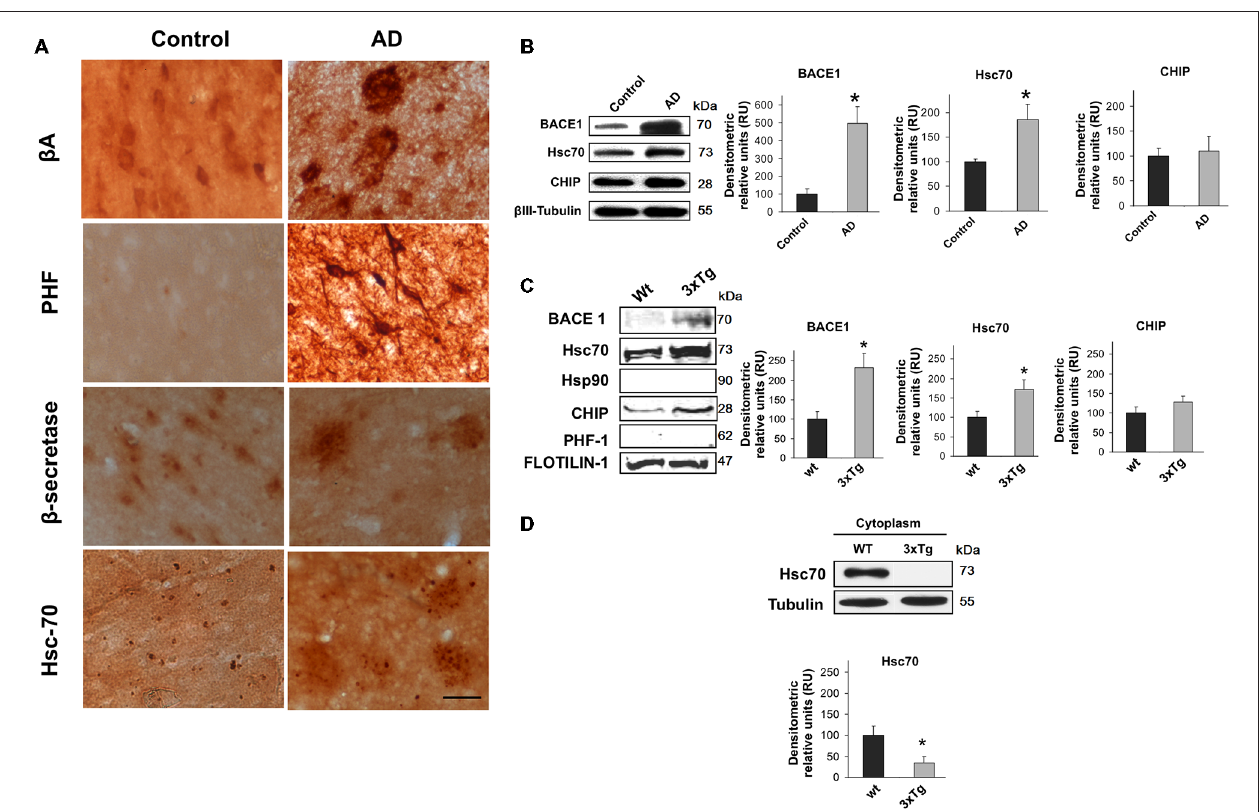
FIGURE 1 | BACE1 and Hsc70 in AD-affected human brains and in lipid rafts from triple-transgenic Alzheimer’s disease mouse brains. (A) β -amyloid, PHF-1, BACE1 and Hsc70 immunoreactivity in the temporal gyrus of AD-affected brains (AD) and control brains. 40 × magnification; scale bar: 20 µ m. n = 4. (B) BACE1, Hsc70 and CHIP Western blotting from the temporal gyrus of AD brains (AD); normal human brains were used as controls. A representative plot is shown. β III-tubulin was used as a loading control. Densitometric quantification was performed; RU = relative units. n = 4, ∗ p < 0.05. (C) Western blotting of BACE1, Hsc70, Hsp90, CHIP and PHF-1 proteins in lipid rafts isolated from the cerebral cortex of 15-month-old wild-type and 3xTg-AD mice. Flotillin-1 was used as a loading control. Densitometric quantification was performed; RU = relative units. n = 3, ∗ p < 0.05. (D) Western blotting of Hsc70 in the cytoplasmic fraction from the cerebral cortex of wild-type and 3xTg-AD mice. RU = relative units. n = 3, ∗ p < 0.05. Representative blots are shown. The arrow shows the band corresponding to the expected molecular weight of the BACE1